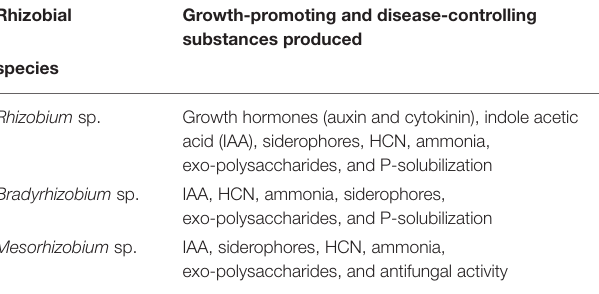
TABLE 6 | Rhizobial species and substances produced for growth promotion and defense against plant diseases. Rhizobial Growth-promoting and disease-controlling substances produced species Rhizobium sp. Growth hormones (auxin and cytokinin), indole acetic acid (IAA), siderophores, HCN, ammonia, exo-polysaccharides, and